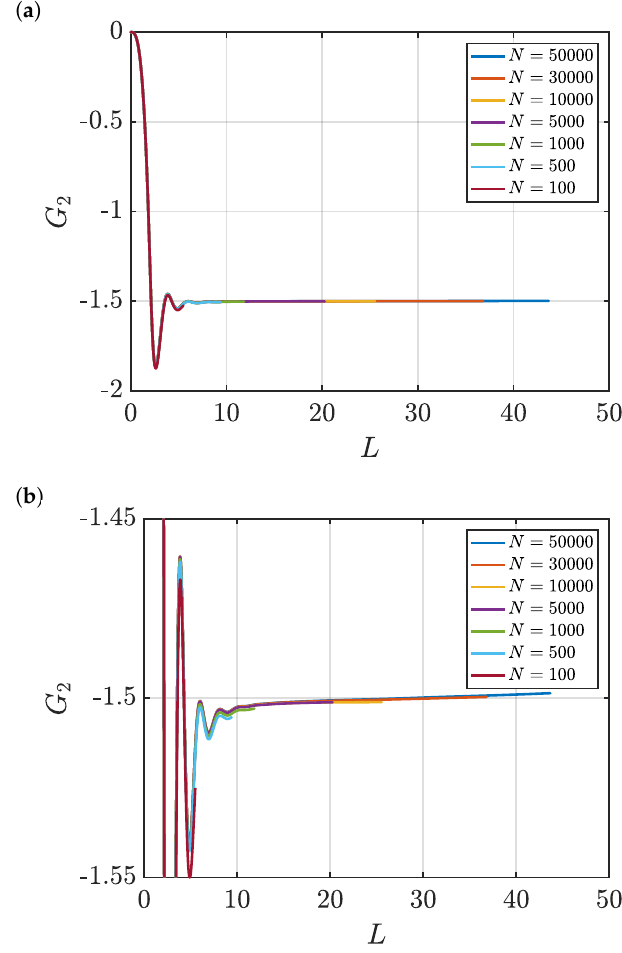
Figure 3. ( a ) Estimation of KB integrals in the thermodynamic limit, G 2 (Equations (6) and (7)) vs. L for the WCA fluid at T = 2 and ρ = 0.6 (dimensionless units). The values of G 2 are computed for systems with varying number of molecules N . The used RDFs are provided in Figure 1. ( b ) A zoom in of the plots in Figure ( a ) is